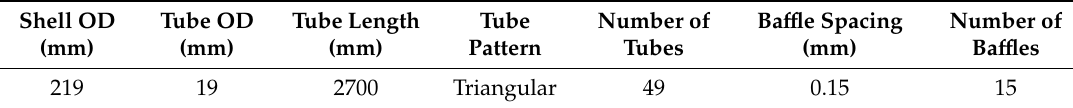
Table 2. Design parameters of the